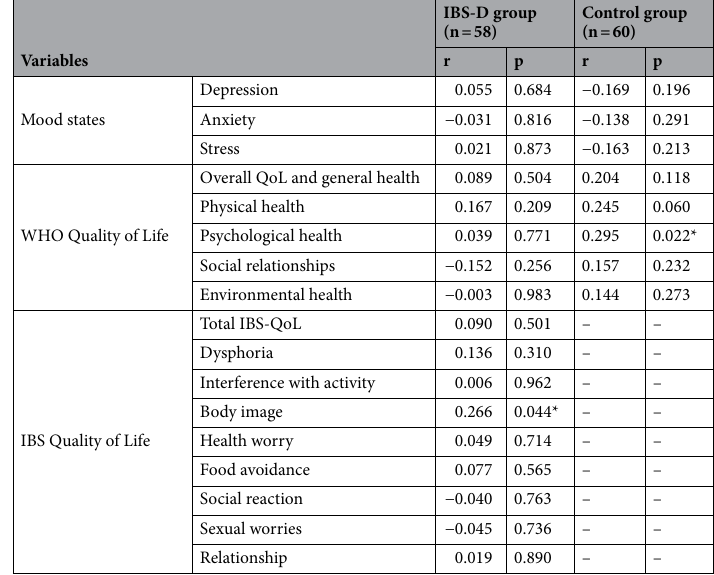
Table 3. Correlation between dietary zinc intakes with depression, anxiety, stress and quality of life. Data are presented as the Pearson’s correlation coefficient (r). *p-value < 0.05.